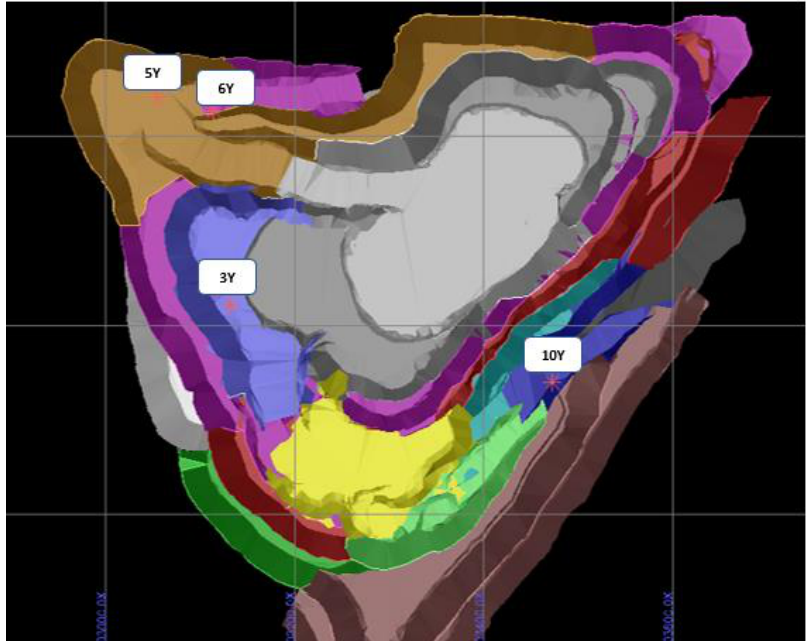
Figure 1. Top view of the stockpile, grid size of 200 m × 200 m. The areas in dark blue, purple, ochre, and light blue indicate the places where the ore has been stockpiled for 10, 6, 5, and 3 years (Y), respectively. Red symbols identify locations from which samples were collected.